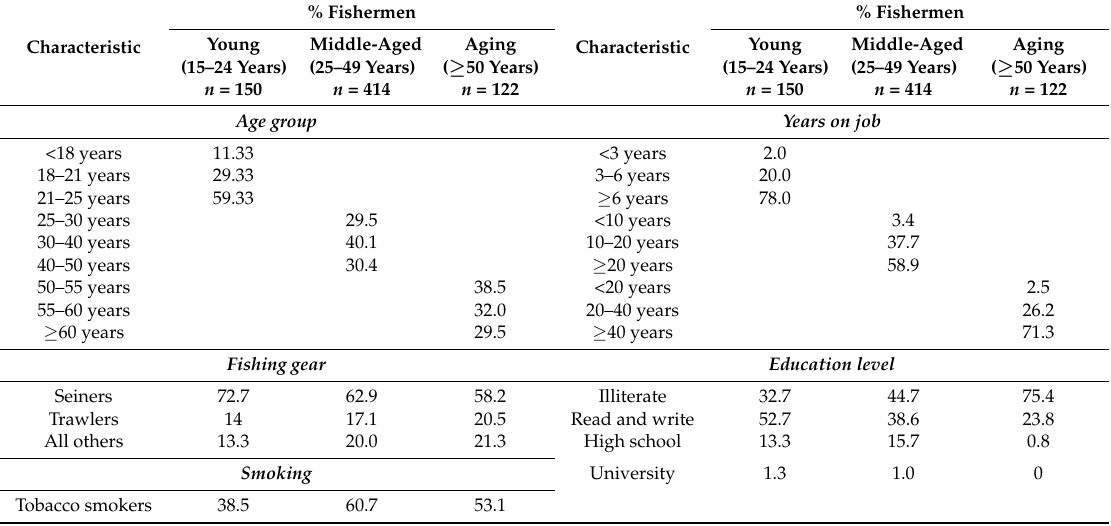
Table 1. Demographic characteristics of the young, middle-aged and aging fishermen sample.